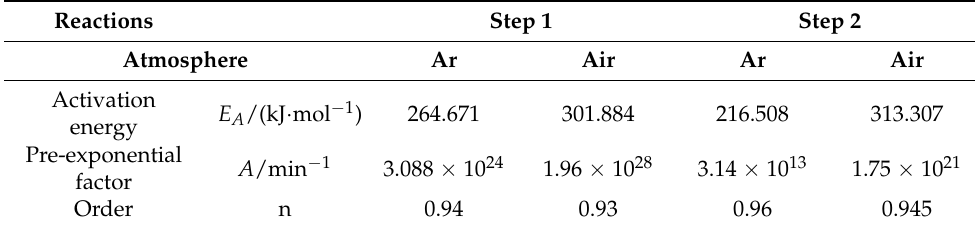
Figure 4. Plots of ln